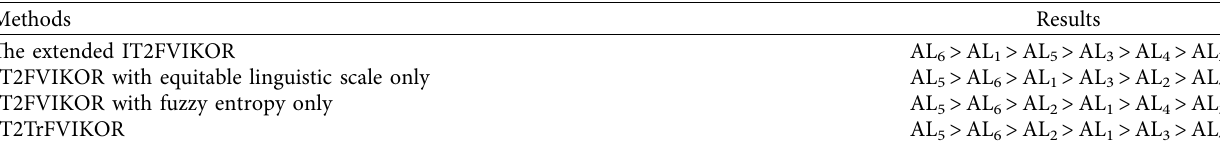
Table 15: Comparative